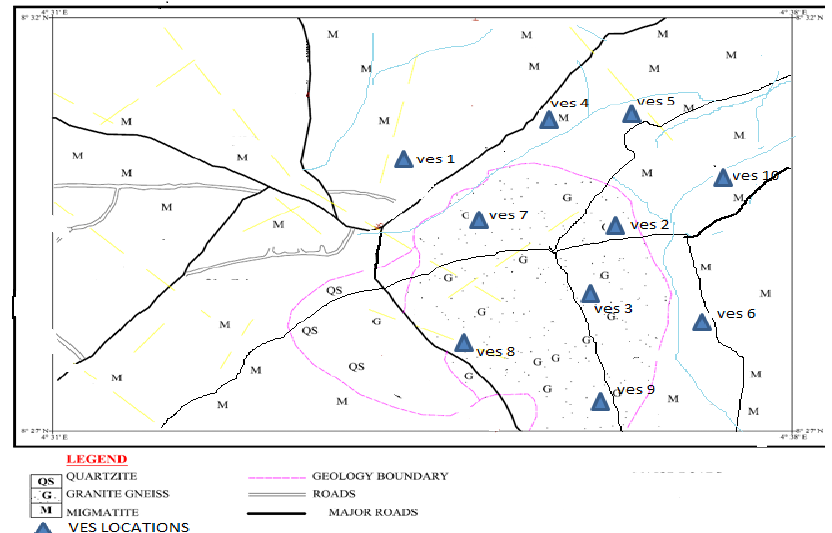
Figure 2: Geological Map of the study